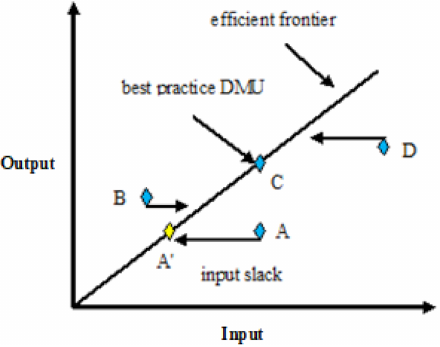
Figure 2. The concept of the Charnes, Cooper, and Rhodes (CCR) input-oriented model of data envelopment analysis (DEA) (single-input and single-output variant).